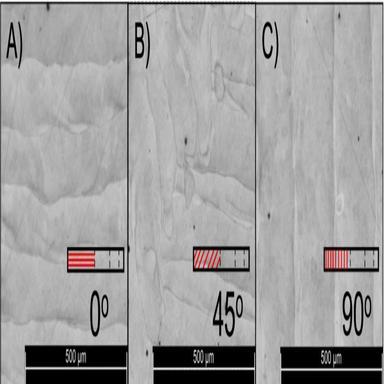
Optical micrograph of maraging steel etched with Nital A) 0◦, B) 45◦ and C) 90◦.